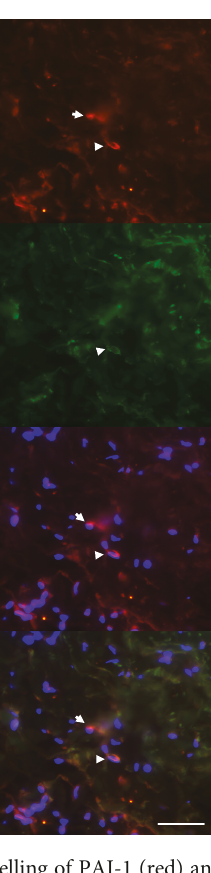
Figure 6: Double-labelling of PAI-1 (red) and α -SMA (green) in an irradiated artery. Arrowheads indicate colocalization of PAI-1 and α -SMA, suggesting expression of PAI-1 in myo fi broblasts. Arrows indicate cells with PAI-1 expression but no α -SMA expression. Nuclear stain (DAPI) is shown in blue (scale bar =50 μ m).